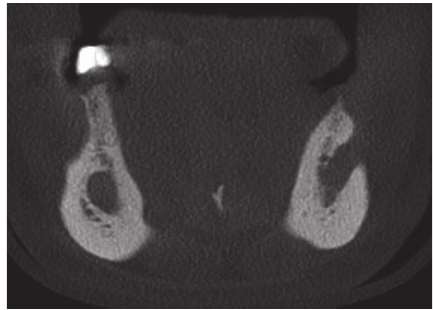
Figure 2: Teleradiograph; the enlargement is also observed.